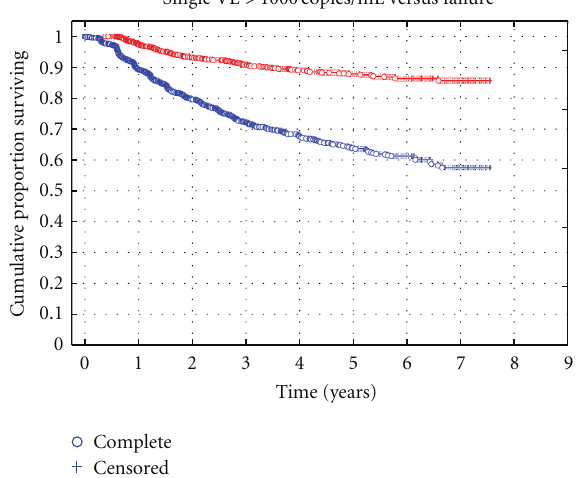
Figure 2: A Kaplan-Meier survival curve depicting risk of an initial virological breakthrough (first viral load > 1000copies/mL after initial suppression—lower curve) and subsequent risk of virological failure (second consecutive viral load > 1000copies/mL—upper curve). Of those with virological breakthrough an expected 66% will resuppress after an adherence